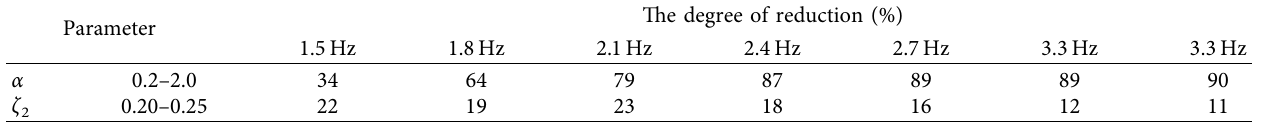
Figure 17: The influence of ζ 2 on structural dynamic responses. Table 5: The max VDV corresponding to variate parameters of active crowd.